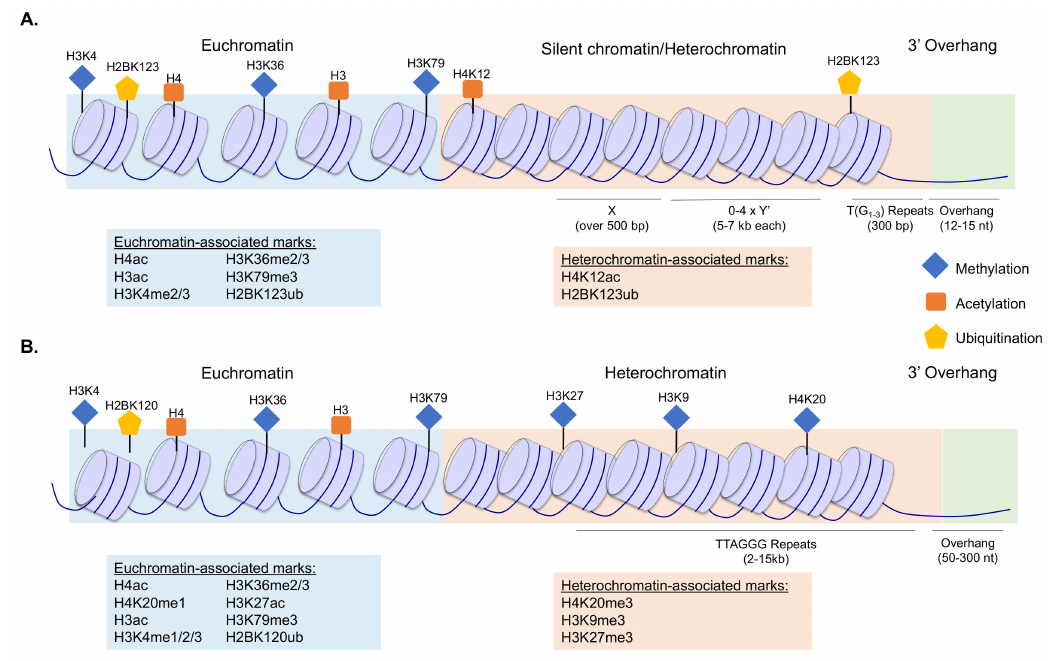
Figure 1. Schematic of budding yeast ( A ) and human ( B ) telomeres and subtelomeres, indicating the primary sequence elements, the general chromatin structure, and the distribution of histone modifications within these regions. Euchromatin-associated and heterochromatin-associated marks are indicated in the figure as shown in the key, and further specified in the text boxes. To improve visualization of the chromatin structure, the telomeres are not drawn as t-loops here. References describing localization patterns of the histone modifications are provided within the main